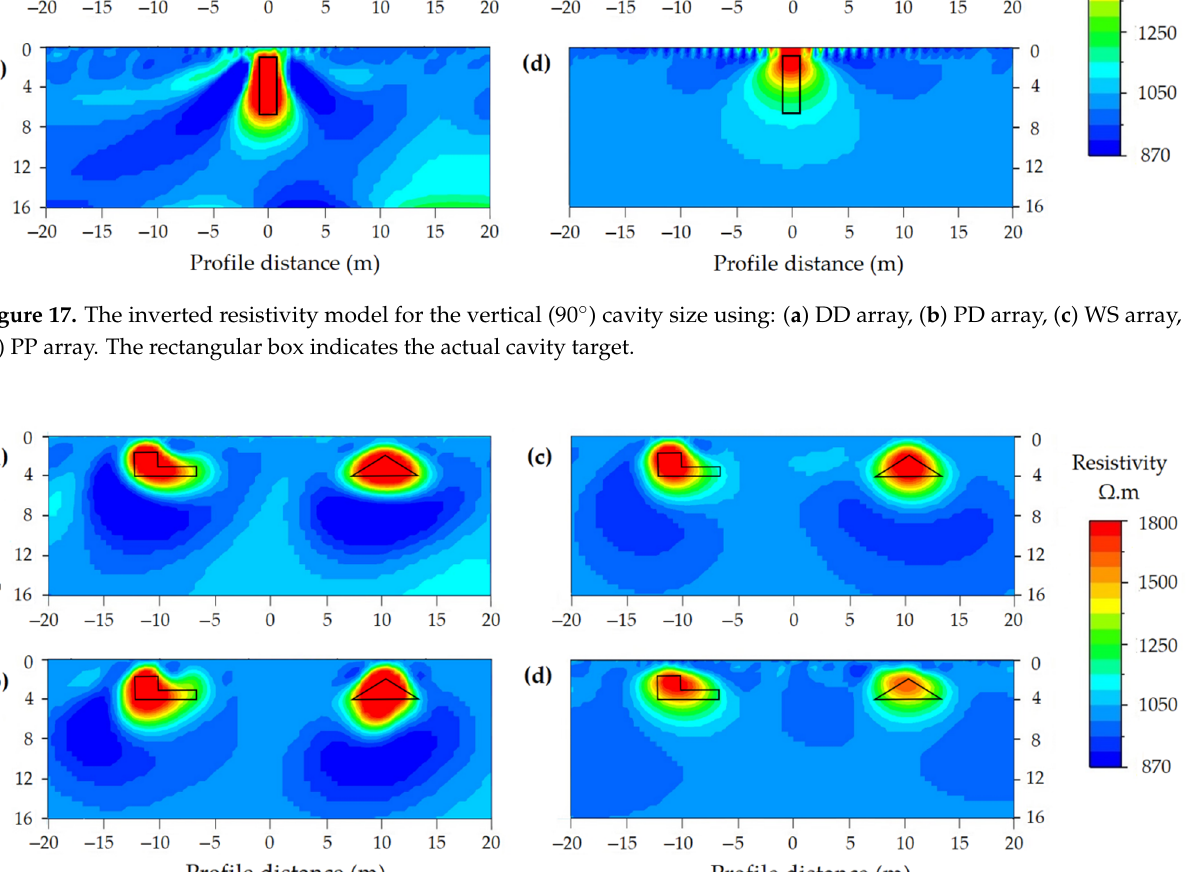
Figure 18. The inverted resistivity models for the cavity geometries using: ( a ) DD array, ( b ) PD array, ( c ) WS array, ( d ) PP array. The solid line indicates the actual cavity targets.